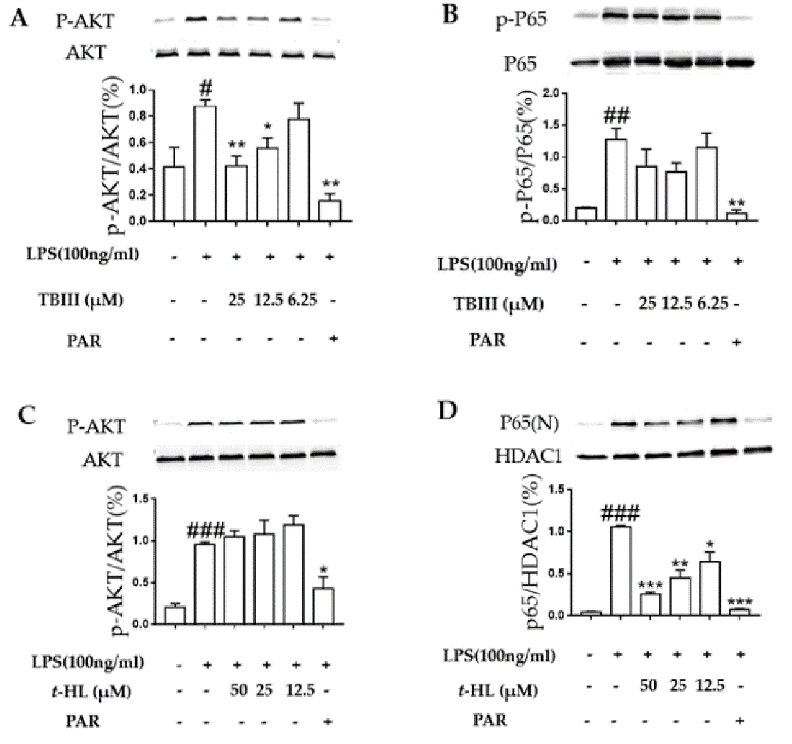
Figure 6. Effect of TBIII and t -HL on LPS-induced activation of Akt ( A,C ) and NF- κ B ( B , D ) in N9 cells. Cells were treated with different concentrations of TBIII and t -HL for 1 h prior to stimulation with LPS (100 ng/mL). Nuclear and cytoplasmic proteins were obtained and analyzed by western blot. PAR (10 µ M) was used as a positive control. The data shown represent the mean ± S.E.M of three independent experiments. * p < 0.05, ** p < 0.01, *** p < 0.001 versus the LPS-treated group; # p < 0.05, ## p < 0.01, ### p < 0.001 versus the control group.